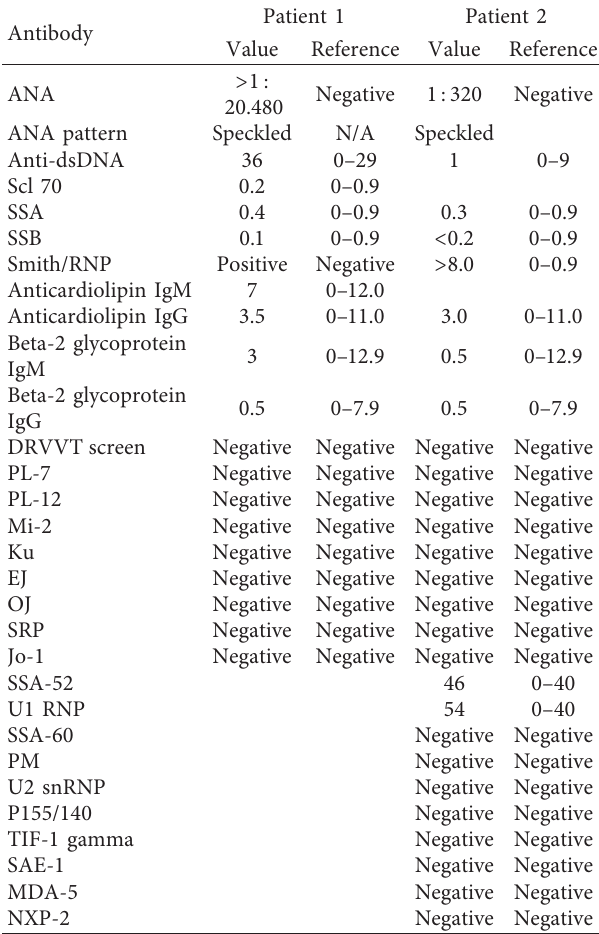
Table 1: Autoimmune antibody profiles for patients 1 and 2.